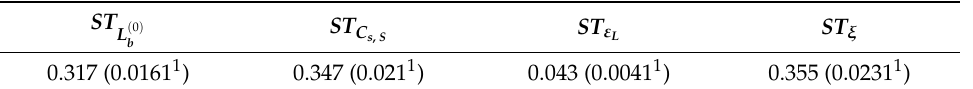
( 0 ) parametrs. S , max